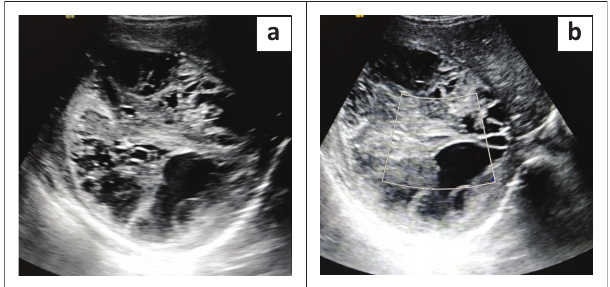
FIGURE 1: (a) A well-defined heterogeneous lesion in the right lobe of liver with solid echogenic areas and anechoic cystic areas; (b) No obvious internal vascularity on Doppler